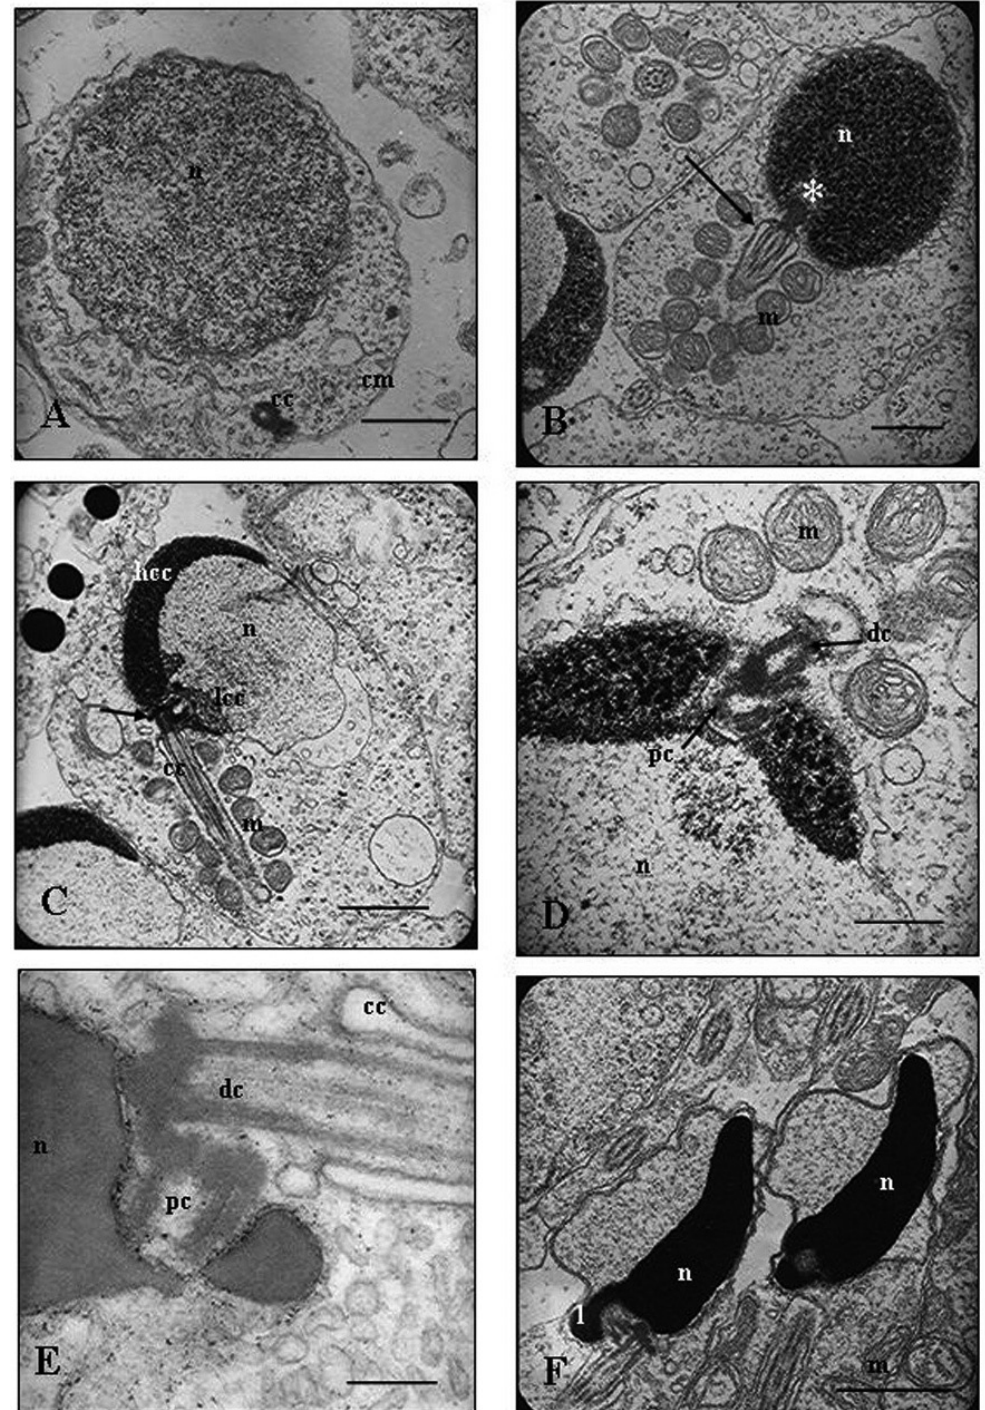
Fig . 1. – A, very early spermatid, showing the centriolar complex in the spermatid plasma membrane ( cc= centriolar complex; cm= cytoplasm membrane; n= nucleus ); B, late spermatid with a nucleus that contains highly condensed, thin fibres of chromatin (m= mitochondria; n, nucleus; *, nuclear fossa; arrow, cytoplasmic channel); C, “U-shaped” nucleus chromatin in a late spermatid, showing different examples of condensed chromatin depending on the site of the nucleus (cc, cytoplasm channel; hcc, high condensed chromatin; lcc, low condensed chromatin; m, mitochondria; arrow, centriolar complex); D, distal and proximal centrioles within the nuclear fossa are not perfectly orthogonal (clu, clusters of chromatin; dc, distal centriole; n, nucleus; pc, proximal centriole); E, high magnification of distal and proximal centrioles of a mature spermatozoon (cc, cytoplasm channel; dc, distal centriole; n, nucleus; pc, proximal centriole); F, mature spermatozoa, showing the lateral nuclear fossa and the nucleus lobule that protects it (f, flagellum; h, head; l, nucleus lobule; m, mitochondria; nf, nuclear fossa). Scale bars: A-C, F, 1 μm; D, 0.5 μm; E, 0.2